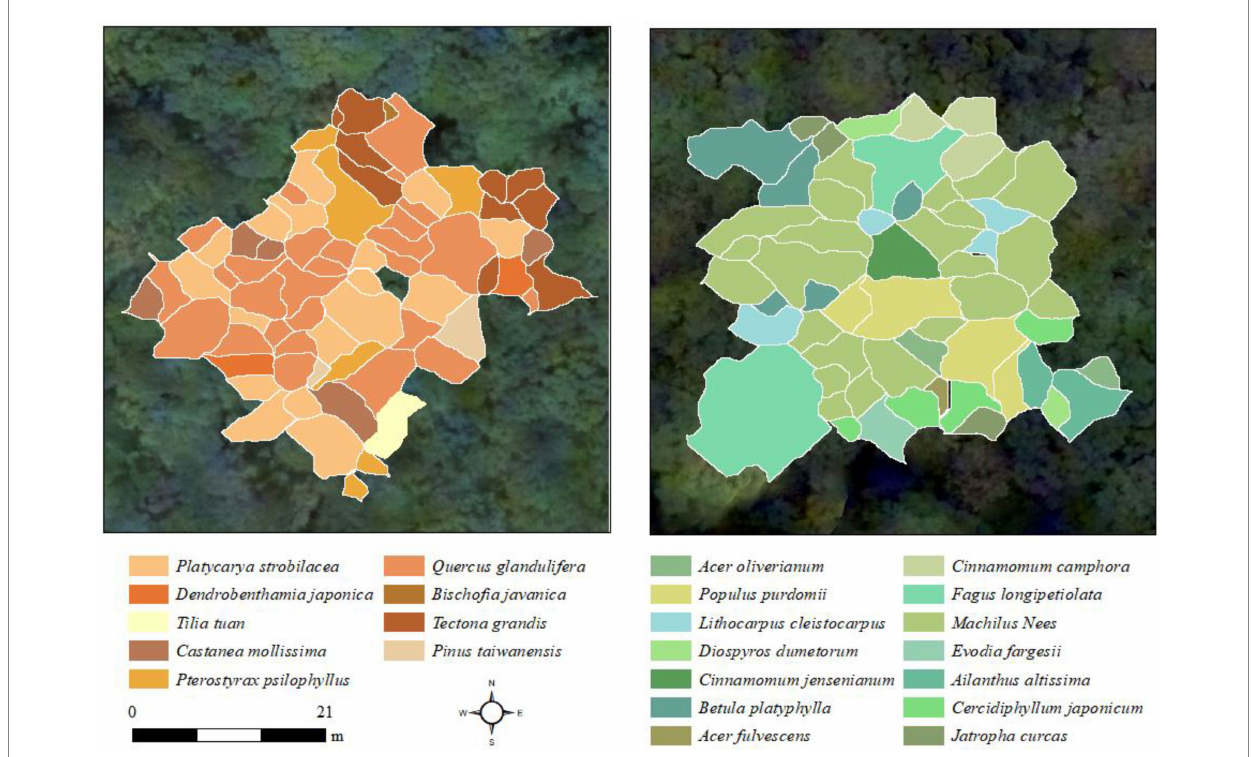
FIGURE 4 Tree species classification results of one sample plot in MZL (left) and one sample plot in GGS (right). Different geometric polygons represent identified ITCs, with white borders indicating the boundaries of the